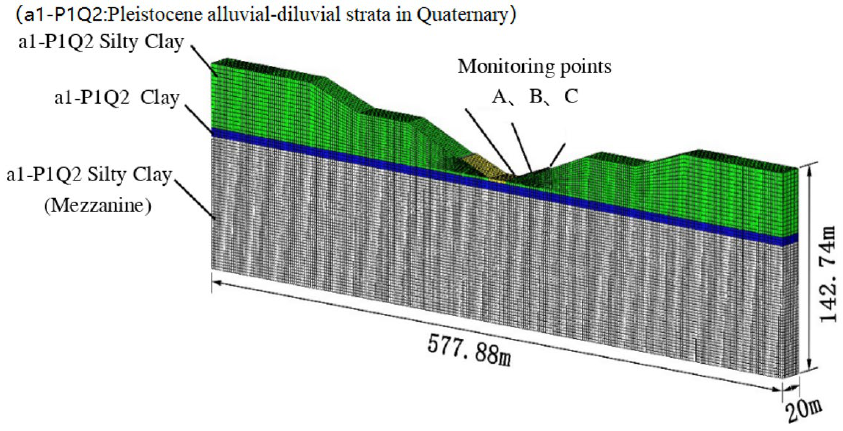
Figure 4. Finite element model of a typical section of the deep excavated canal .